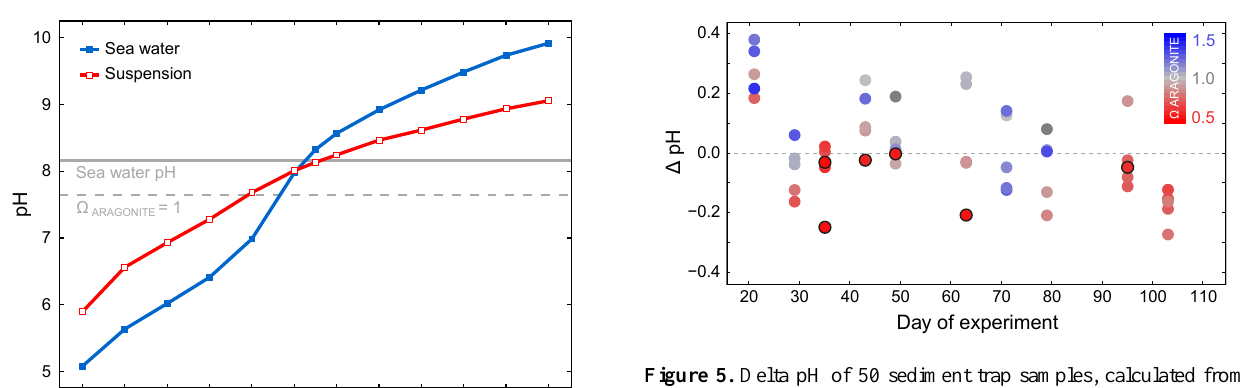
Figure 5. Delta pH of 50 sediment trap samples, calculated from pH measurements before and after addition of FeCl 3 (300µLL − 1 , 2.4M) and NaOH (660 µLL − 1 , 3M) for precipitation of suspended particulate material. (cid:127) ARAGONITE after chemical treatment of the samples is indicated by a colour gradient from red to grey to blue, representing undersaturated, saturated, and oversaturated samples, respectively. (cid:127) CALCITE <1 is indicated by black edging of the coloured data